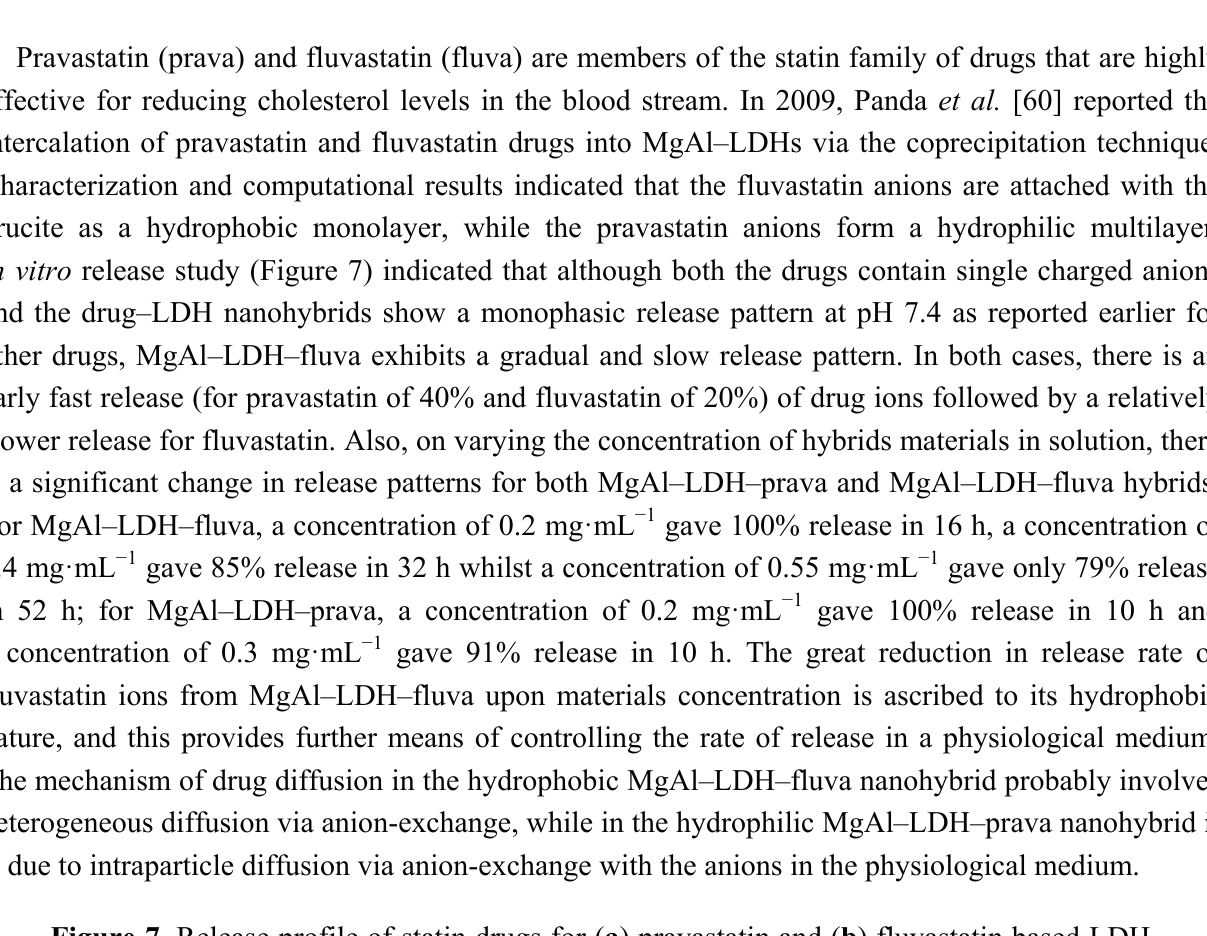
Figure 7. Release profile of statin drugs for ( a ) pravastatin and ( b ) fluvastatin based LDH systems under various physiological conditions. Reprinted with permission from [60] (Copyright 2009 American Chemical